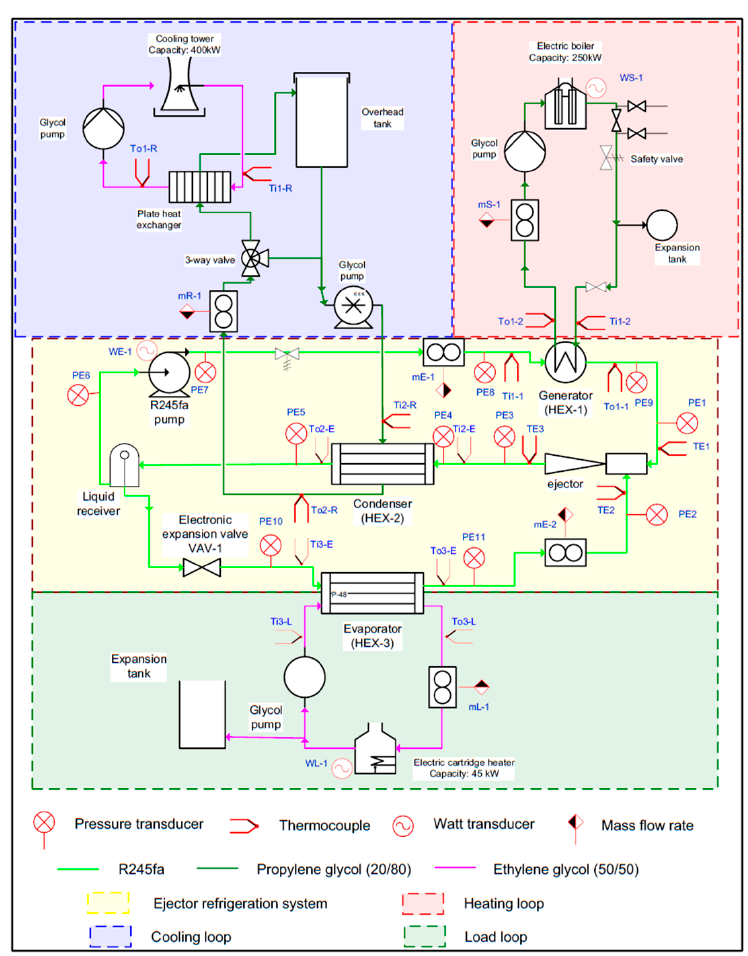
Figure 28. ERS prototype with R245fa [256].